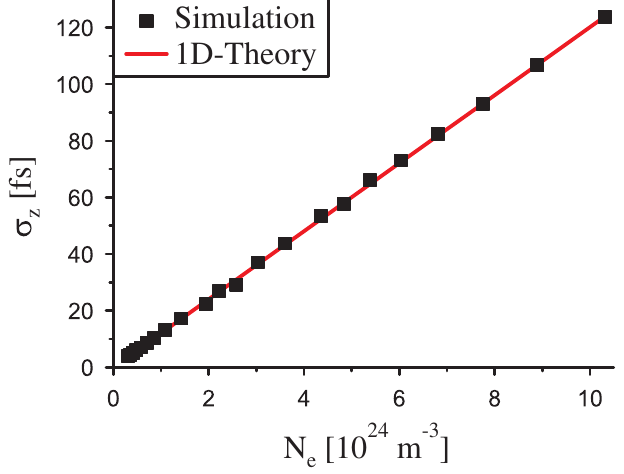
FIG. 6. (Color) Final bunch length of a 500 fs injected electron bunch after compression as a function of the density/propagation speed of the plasma wave. The solid line is the behavior predicted by 1D theory [Eq.